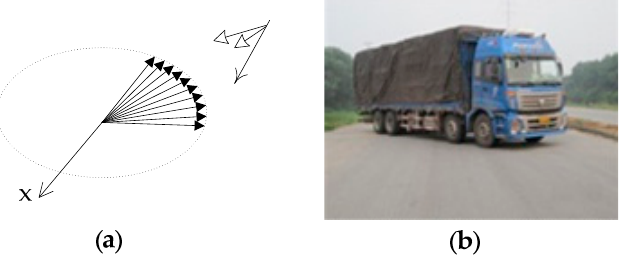
Figure 3. Ten trucks parked at continuous aspect angles and imaged by SAR in Experiment II and III at different incidence angles. ( a ) The geometric relationship between the SAR illumination direction and truck parking angle; and ( b ) a larger truck with a rectangular cuboid shape.